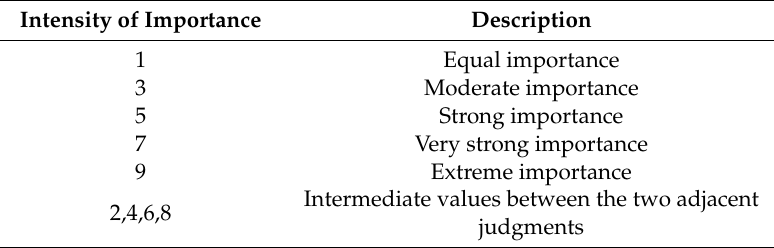
Table 1. Fundamental scale / parameters influence ranking [15].